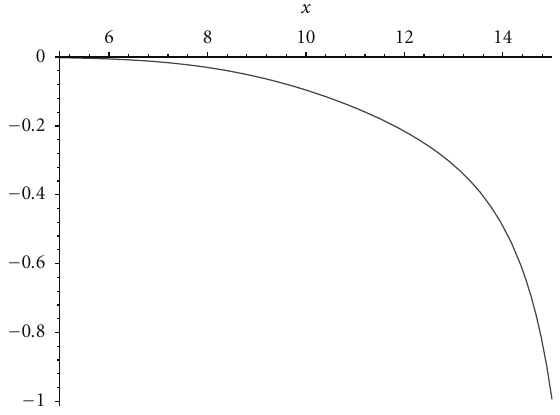
Figure 2: Optimal controls u ∗ t (solid line) when x = 0, b 0 = q 0 = σ 0 = μ = 1, d = 5, and t